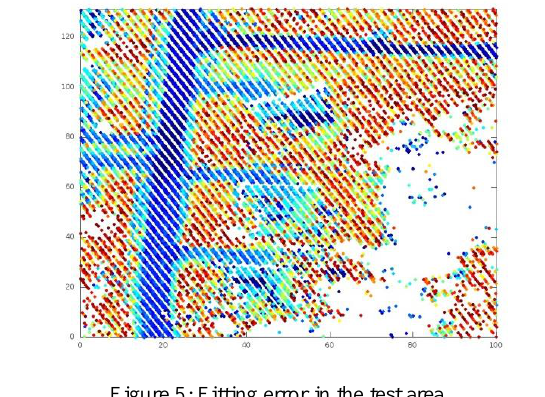
Figure 5: Fitting error in the test area